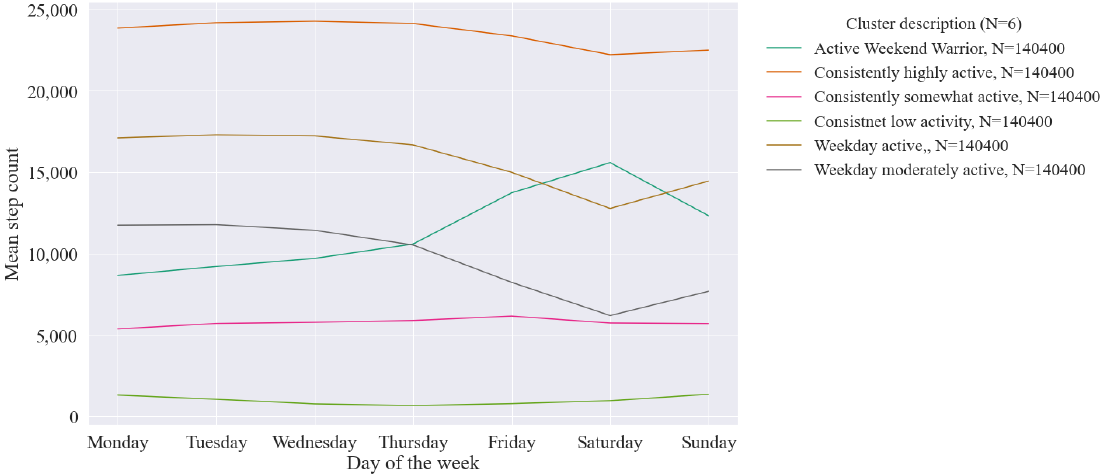
Figure 7. Average daily step counts for k-means weekly physical activity behaviour clusters (N = number of weeks of behaviour assigned to each cluster).